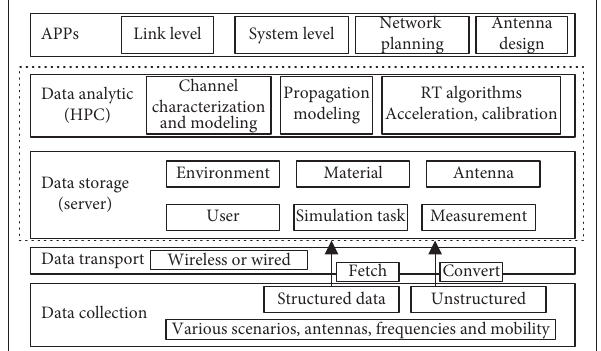
Figure 1: Data workflow of RT